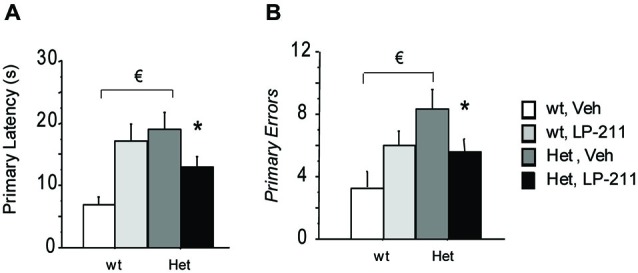
Stimulation of the 5-HT7 receptor by LP-211 improves spatial memory of MeCP2-308 female mice in the Barnes Maze test. MeCP2-308 female mice (Het, Veh) displayed longer primary latencies (A) and a higher number of primary errors (B) to locate the virtual target hole (first nose poke in the virtual target hole) during the Probe tests. LP-211 treatment partially restored the levels of both parameters in Het mice (A,B). Mice for each condition were as follows: wt, Veh = 9; wt, LP-211 = 11; Het, Veh = 12; Het, LP-211 = 10. Data are means ± SEMs. € : wt, Veh vs. Het Veh, p < 0.05 and * : Het, Veh vs. Het, LP-211, p < 0.05.